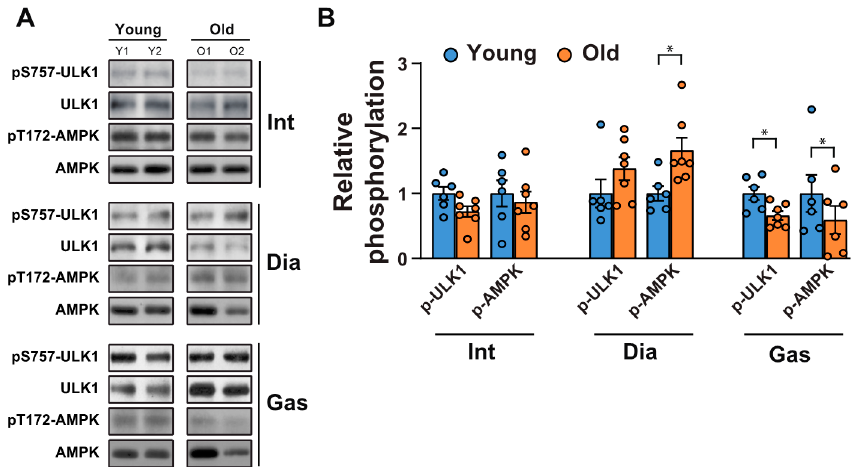
Figure 4. Changes in autophagy initiating signaling between the respiratory muscles and gastrocnemii with age. ( A ) The intercostal, diaphragm, and gastrocnemius muscles were lysed and subjected to Western blot analysis ( n = 6). ( B ) The relative intensities of the bands were quantified using the ImageJ analysis software ( n = 6). Data are presented for pSer757-ULK1 compared to those for ULK1 and for pThr172-AMPK compared to those for AMPK. The data are shown as the mean ± standard deviation. Statistical analysis was performed using unpaired Student’s t-test. * p < 0.05; 6-month-old versus 20-month-old rat muscles. Abbreviations: diaphragm muscle (Dia); gastrocnemius muscle (Gas); intercostal muscle (Int); 6-month-old rat (Young); 20-month-old rat (Old).